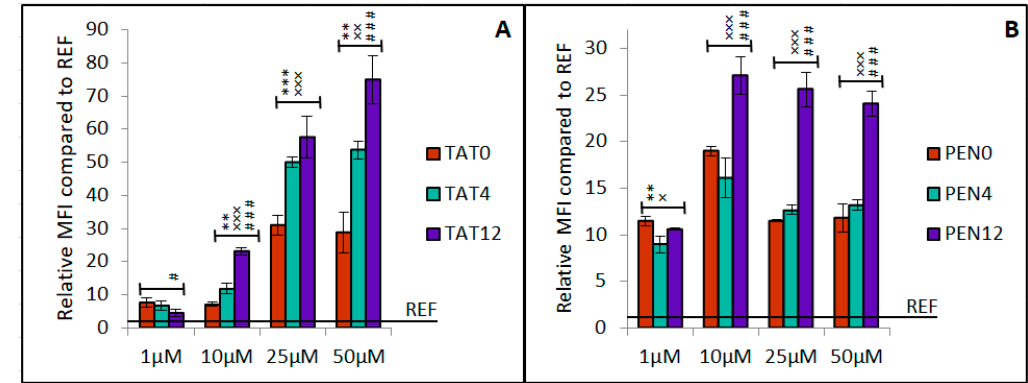
Figure 3. Comparison of fluorescently labeled peptide–polymer conjugates incubated with HeLa cells at 4 °C for 1 h documenting level of uptake for various spacer lengths. The heights of the columns show a relative increase of the median fluorescence intensity (MFI) of the cells incubated with the polymer–peptide conjugates compared with control polymer REF (value = 1) in respective concentrations. Panel ( A ) refers to conjugates decorated with TAT, panel ( B ) to conjugates with PEN. The level of significance is shown for each combination: * for 0 vs. 4; × for 4 vs. 12, and # for 0 vs. 12. Polymer–peptide conjugates against REF were significant in all cases for p < 0.001; the only exception is the 1- μ M concentration of TAT-bearing conjugate, where TAT4 vs. REF is p < 0.01 and TAT12 vs. REF is p < 0.05.